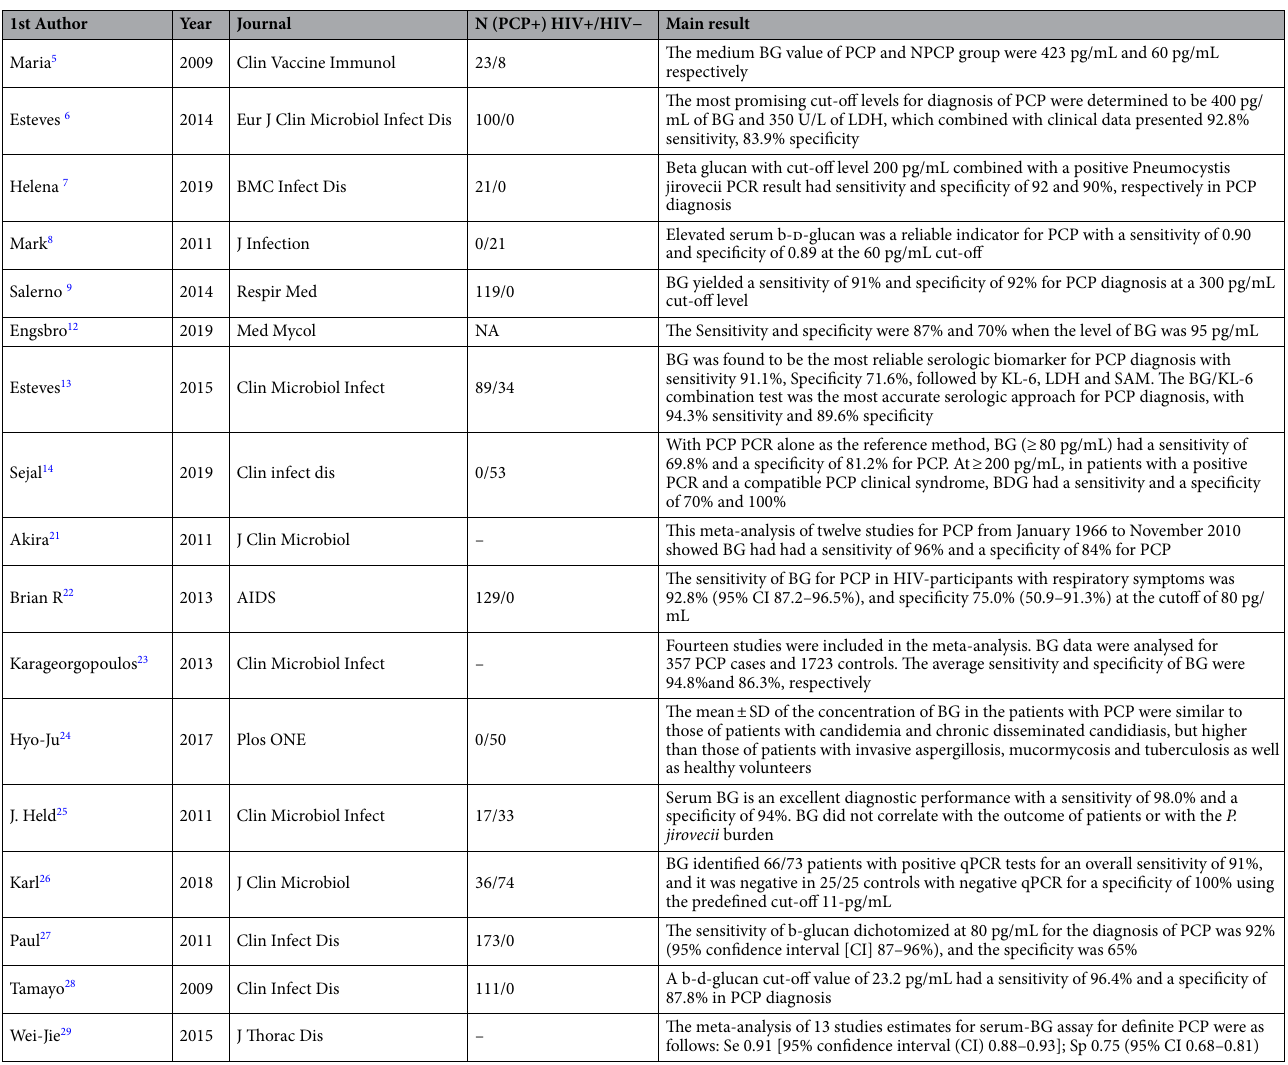
Table 3. An overview of recent literatures on serum BG as a marker for